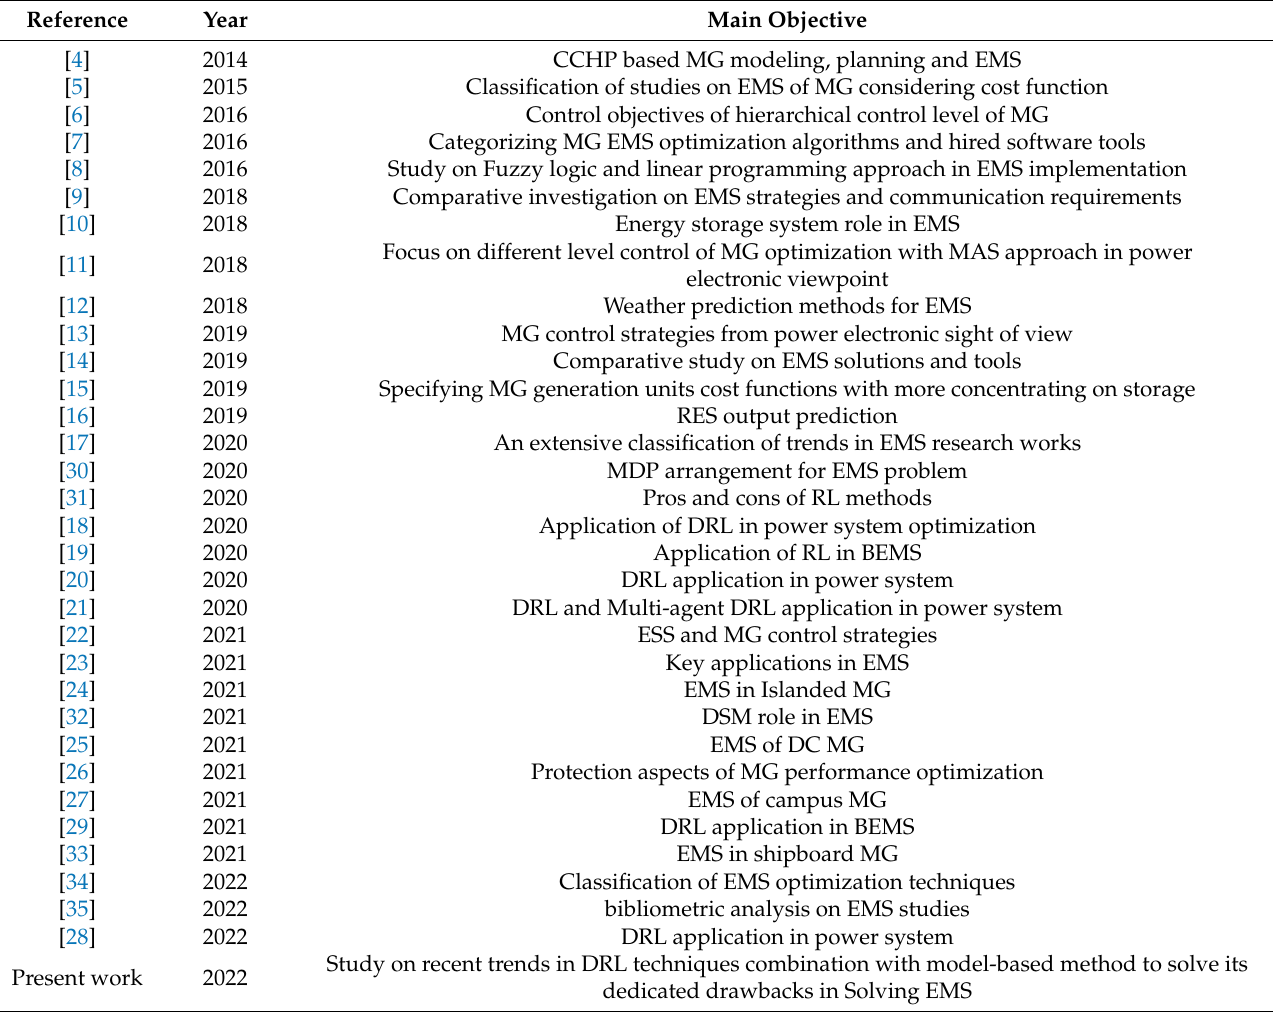
Table 1. Related work objectives—a